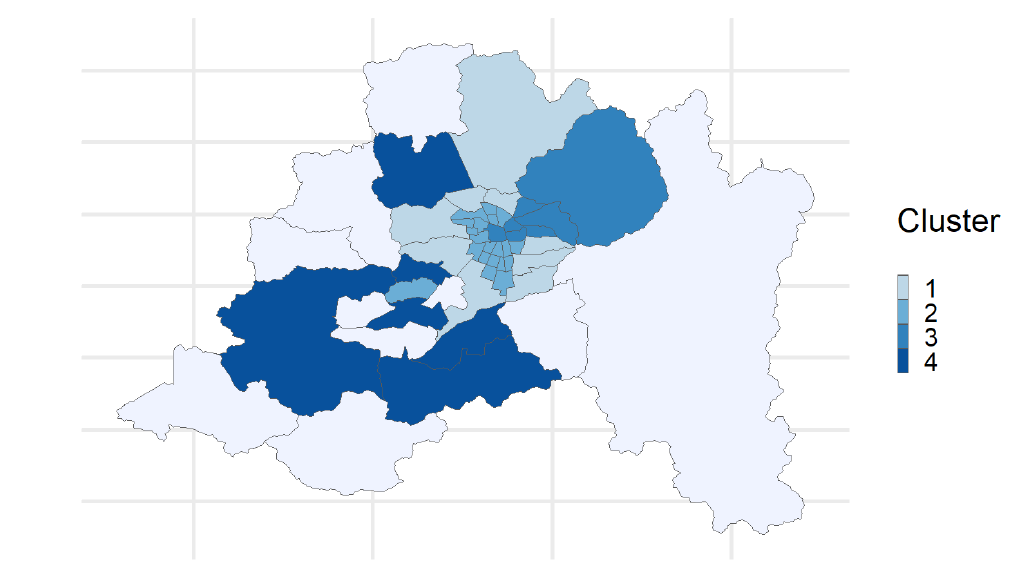
Figure 15. Clusters distributed in Metropolitan